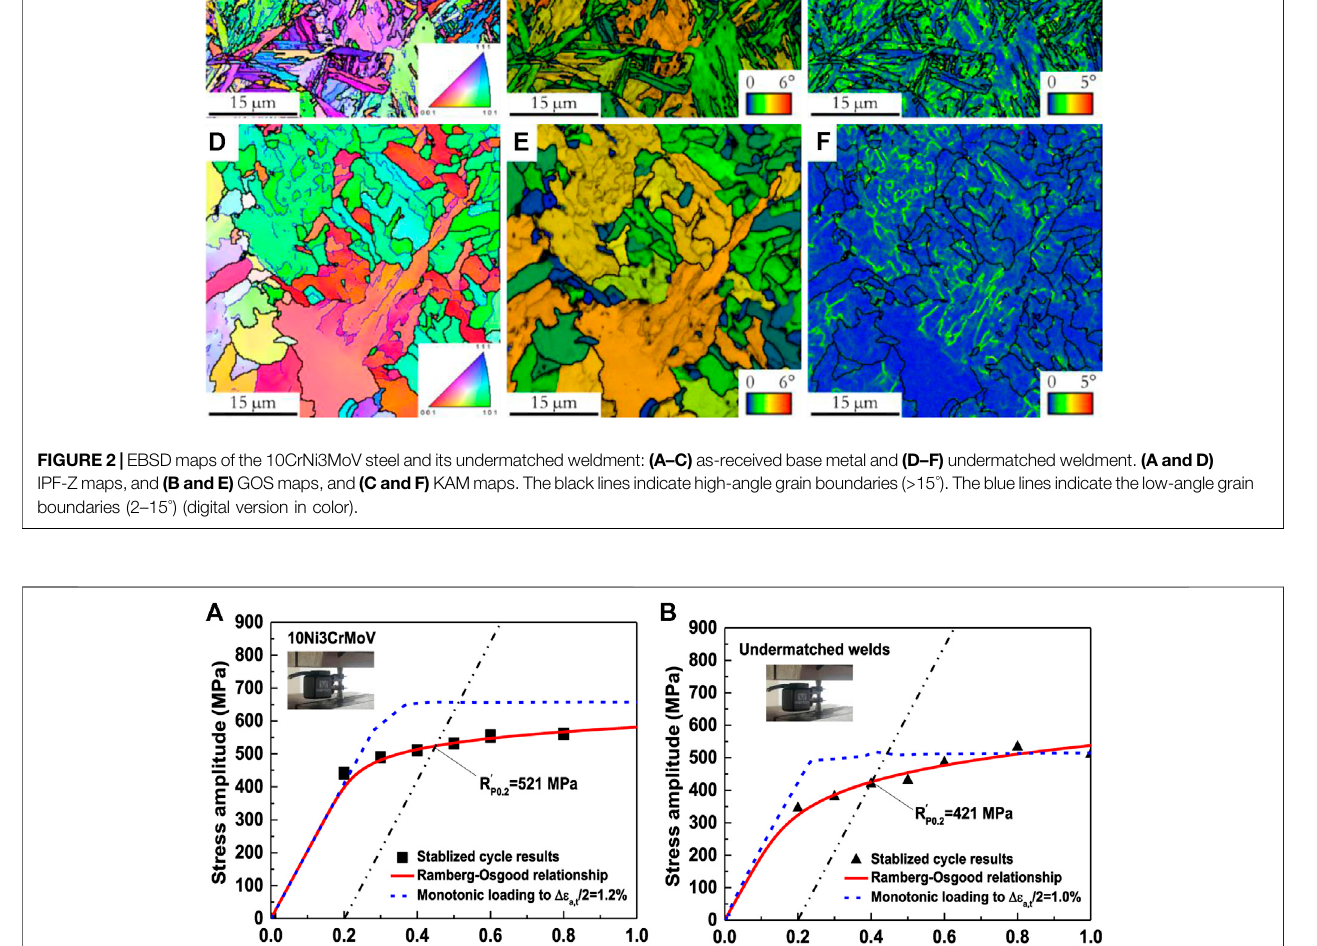
Frontiers in Materials |